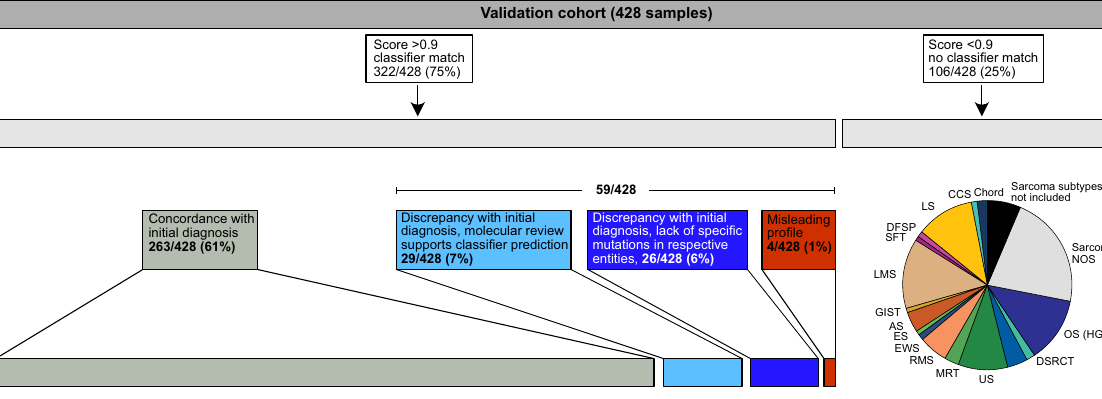
Fig. 3 Validation of the sarcoma classi fi er. In total, 426 independent sarcoma samples were analysed. 75% matched to an established DNA methylation class with a classi fi er prediction cut-off score of ≥ 0.9. 25% reached a classi fi er prediction cut-off score of <0.9. Abbreviations are identical to Fig.